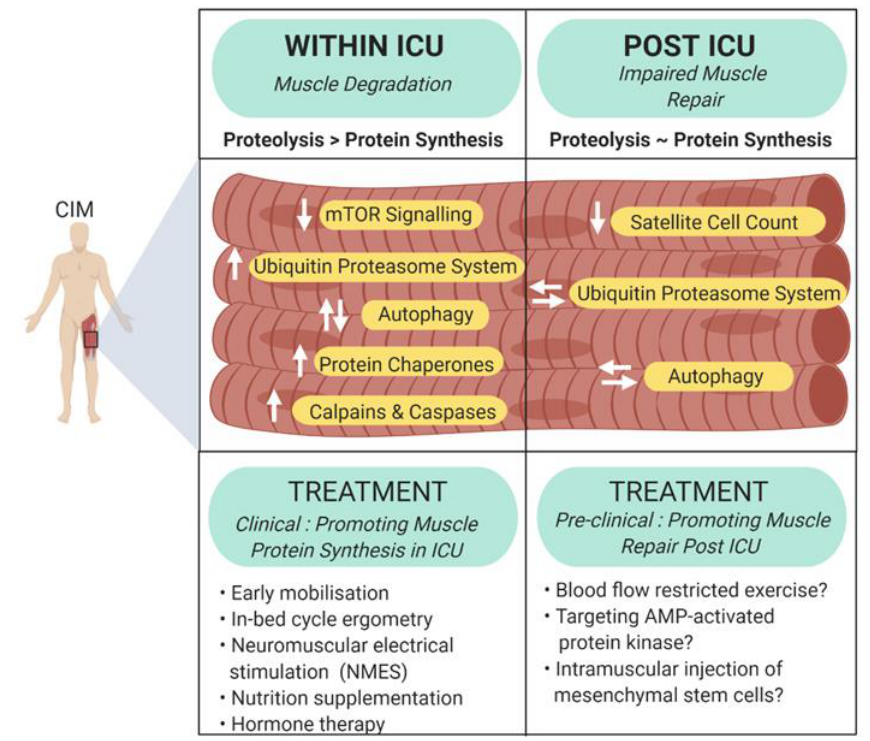
Figure 2. Summary of known molecular mediators of muscle wasting in critical illness. Muscle atrophy is a major myogenic component of critical illness myopathy. Concurrent with intensive care unit stay, muscle degradation occurs due to proteolytic activity outweighing protein synthesis, whereas impaired muscle repair contributes to sustained weakness following intensive care unit discharge. Double vertical arrows represent dysregulation and double horizontal arrows indicate stabilization.